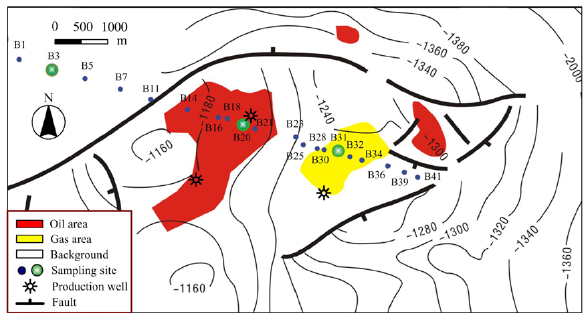
Figure 1. Geological base of Shaozhuang Oil and Gas Field and sampling scheme for spatial analysis of n-alkane degrading bacterial community. Sampling positions for clone library analyses of alkane hydroxylase ( alkB ) gene diversity at three different sites are marked with green circles. Small blue circles indicate the soil samples for T-RFLP and qPCR analysis. The thinner black lines and related negative 4 digits number are contour lines. Soils were collected at a depth of 60 cm.